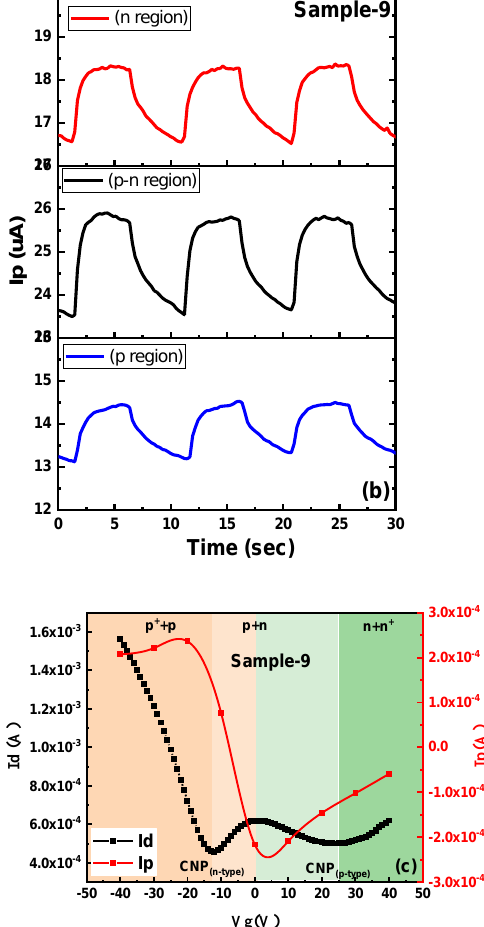
Figure 8. Photo-current (I p ): ( a ) V g dependent Ip measured for fabricated pn-junction devices (sample-9 and sample-10). ( b ) I p as a function of time with a bias voltage Vd of 1V in the dark and illuminated states during the measurement. The I p for the pn-region is readily enhanced because of photo-generated electron-hole pairs in the channel. ( c ) V g dependent I d and I p for the fabricated pn-junction device (sample-9), for different regions of the device.